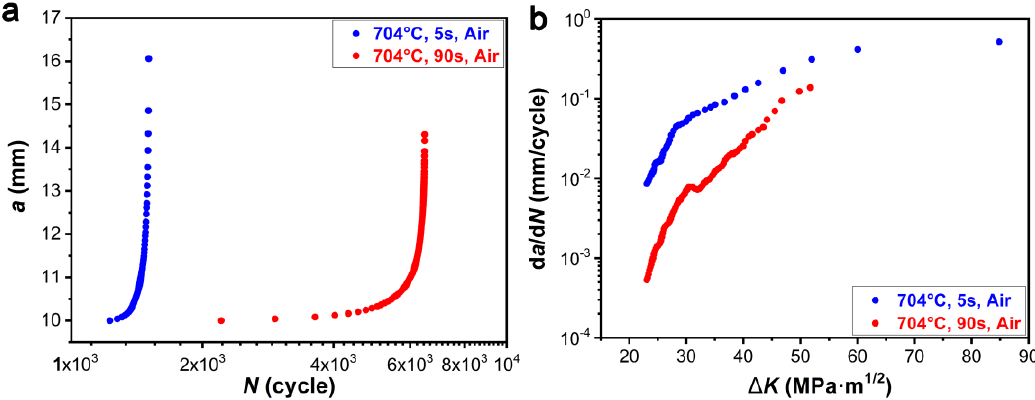
Figure 4. ( a ) a - N curves and ( b ) DFCGR curves with different hold-times (5 s, 90 s) of 718Plus alloy in air.